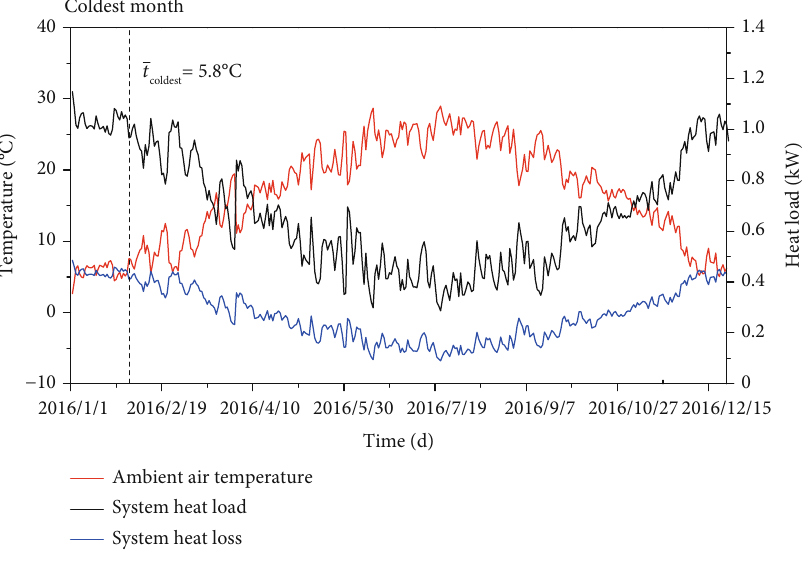
Figure 10: Annual heat duty and heat loss of the